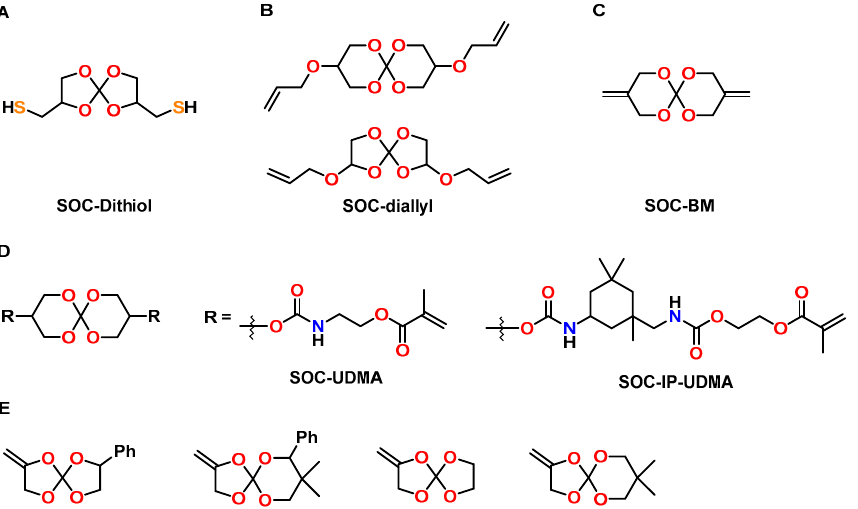
Figure 19. A – E : Chemical structure of SOC monomers used as anti-shrinkage additives in acrylic-based dental resins and composites. A mixture of SOCs with five and six-membered rings bearing two allyl groups (SOC- diallyl) was used to reduce the shrinkage of acrylic dental resins (ratio bis- GMA:UDMA:TEGDMA = 50:30:20) by Ortiz, Gonzales and coworkers (Figure 19B) [99].